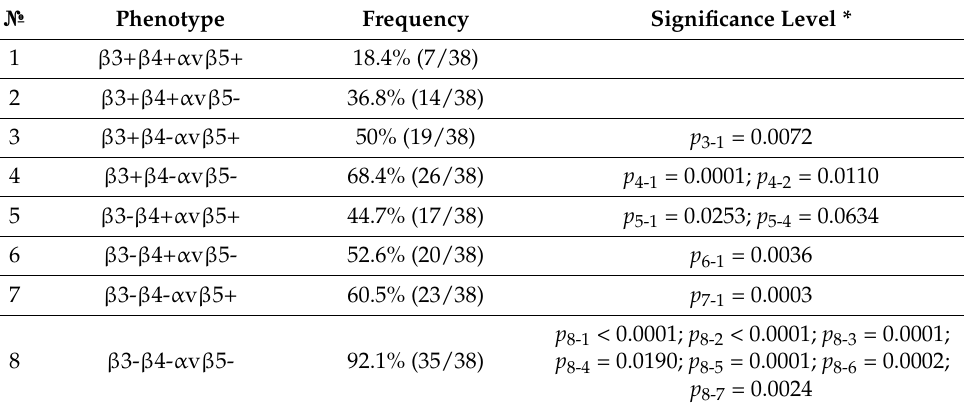
Table 3. Frequency of occurrence of β 3, β 4, and α V β 5 integrins co-expression on CTCs of breast cancer